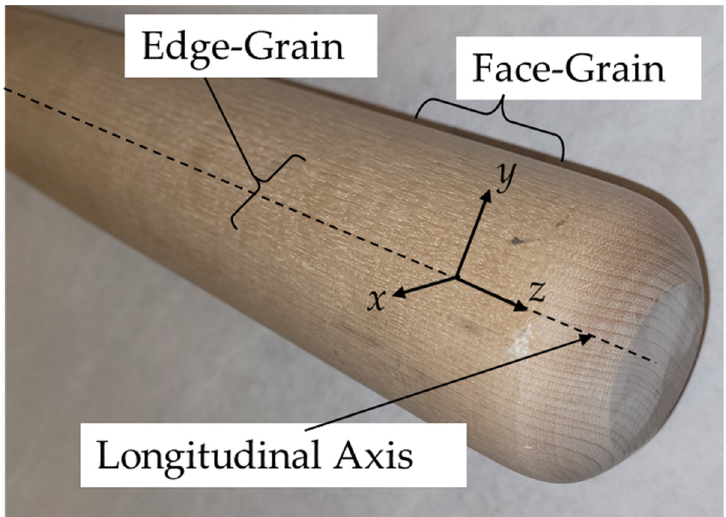
Figure A1. Wood grain identification. Table A1. Finite Element Model Material Properties in US Customary